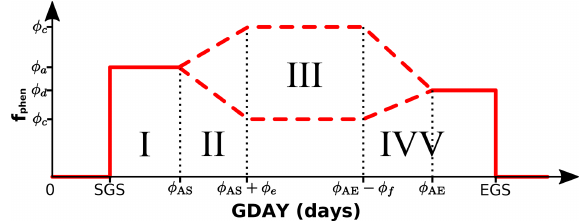
Figure 1. Sketch of the five different phases in plant phenology f phen in accordance with Eq. (18).